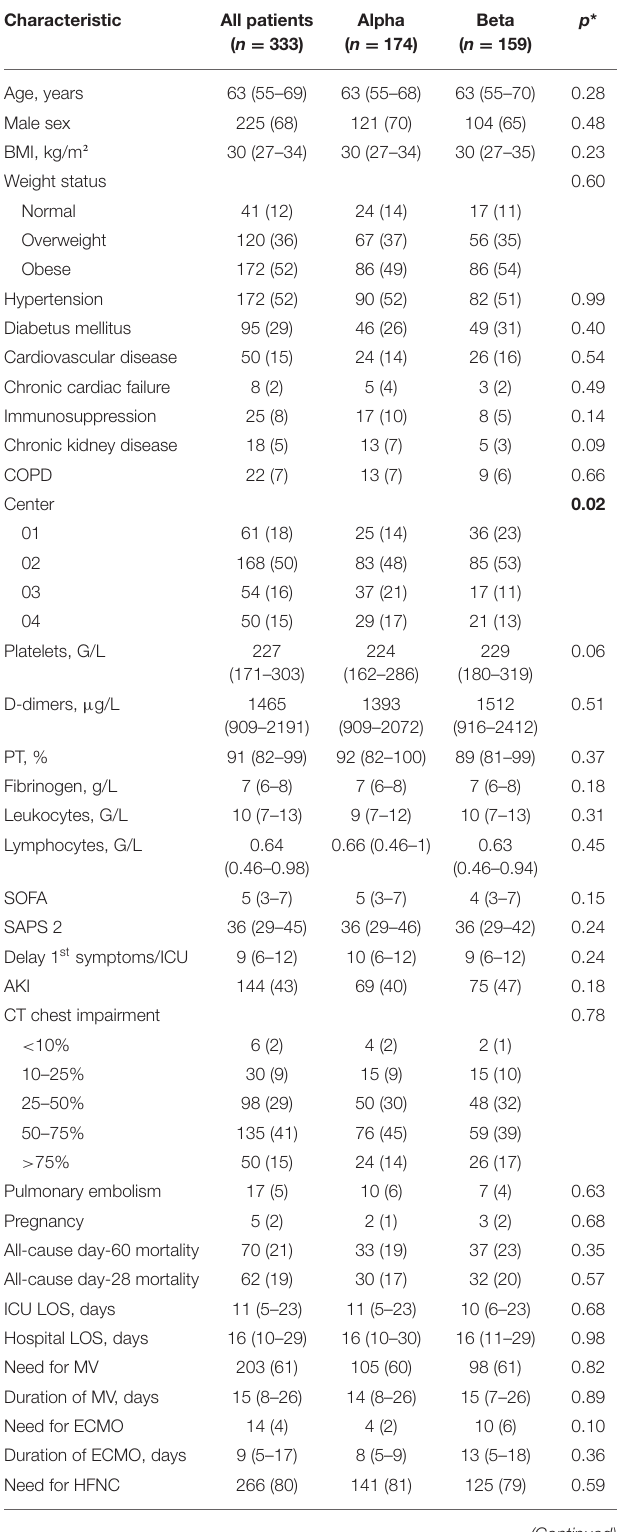
TABLE 1 | Comparison of the Alpha- and Beta-infected patients in terms of their demographic, comorbidity, and characteristics on ICU admission and their primary and secondary